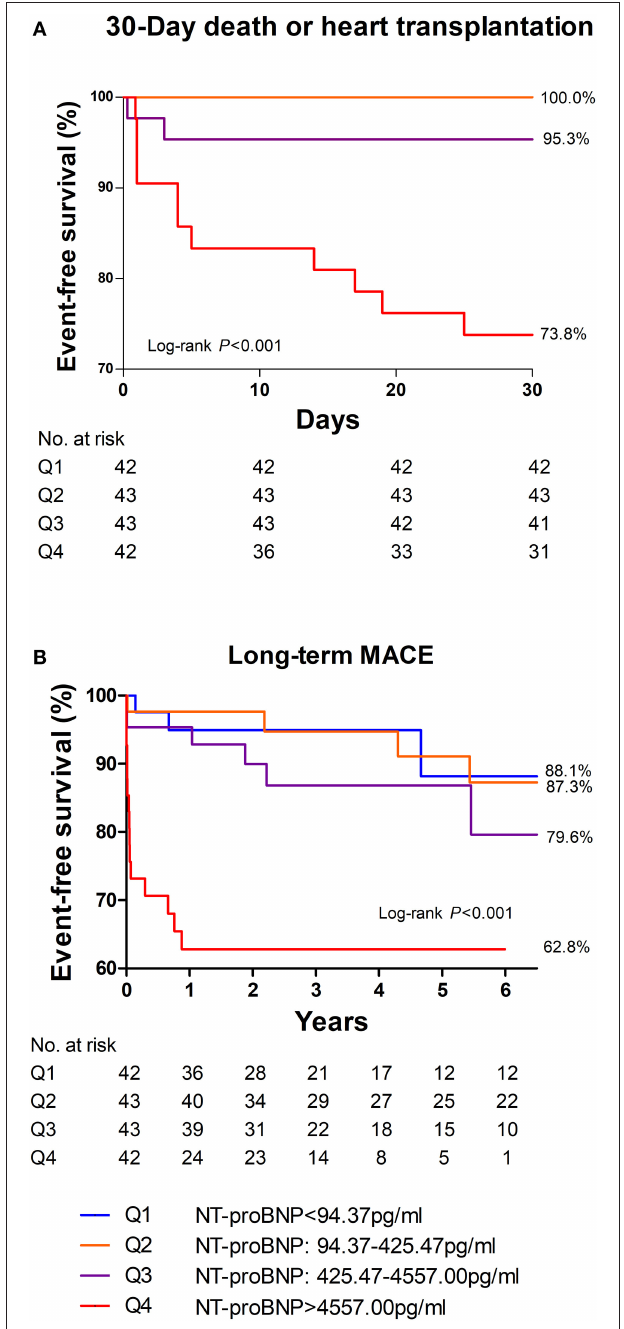
FIGURE 3 | 30-day (A) and long-term (B) MACE-free survival among different quartiles of NT-proBNP in patients with acute myocarditis. Patients in the highest quartile of NT-proBNP had the most MACE in 30 days as well as in the long-term. Thirty day MACE included deaths and heart transplantation within 30 days after admission. Long-term MACE included deaths, heart transplantations, re-hospitalization for heart failure, and sustained ventricular arrhythmias ( >